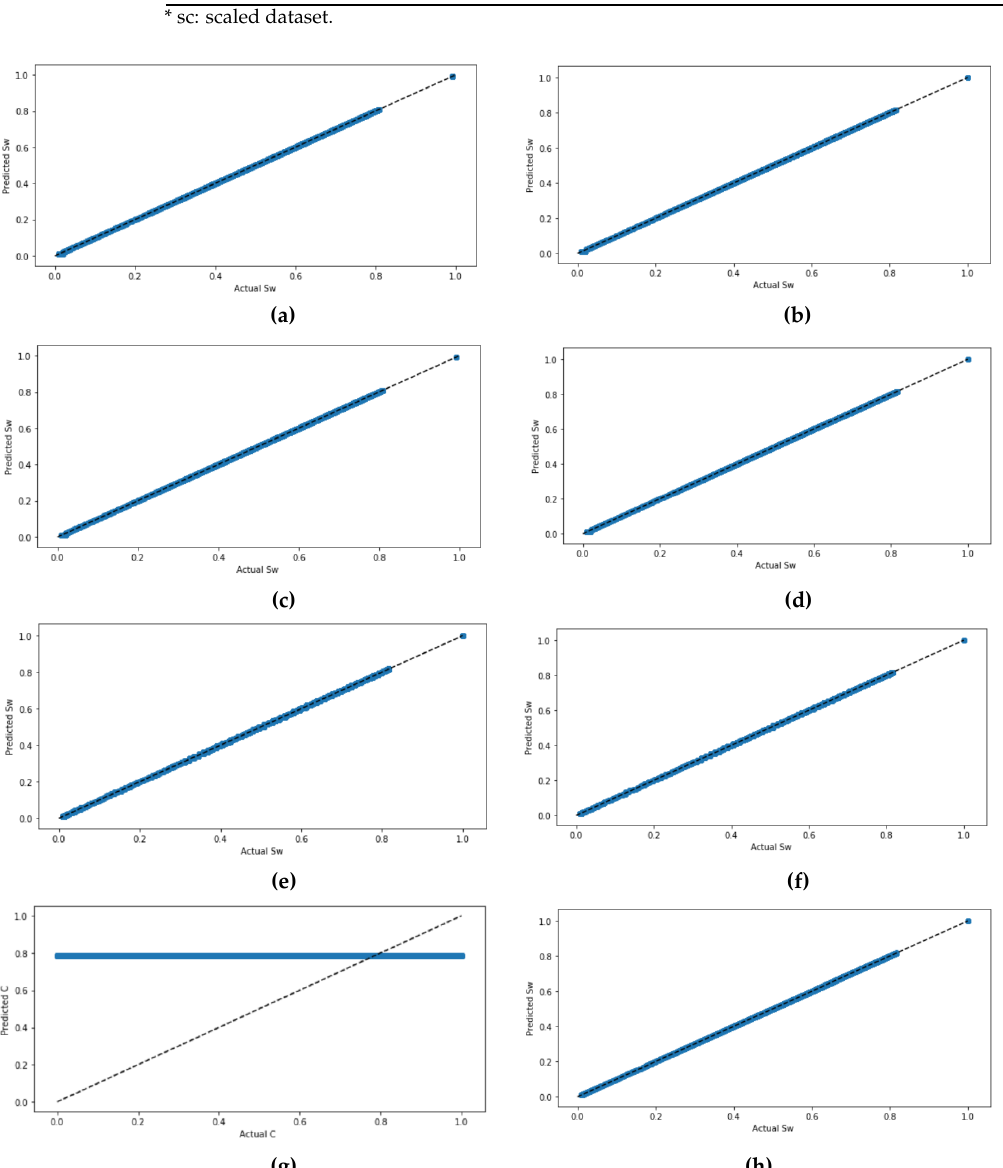
Figure 5. Actual vs. predicted water saturation using machine learning techniques DT, RF, GBR, and ANN for S w . ( a ) DT without scaling, ( b ) DT with scaling, ( c ) RF without scaling, ( d ) RF with scaling, ( e ) GBR without scaling, ( g ) GBR with scaling, ( f ) ANN without scaling with tan h , ( h ) ANN scaling with tan h. The dashed line represents a full coinciding between actual and predicted data.